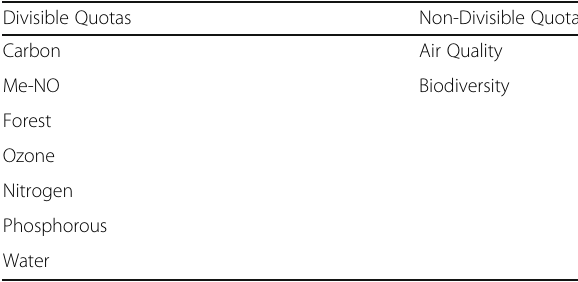
Table 4 Divisible and non-divisible